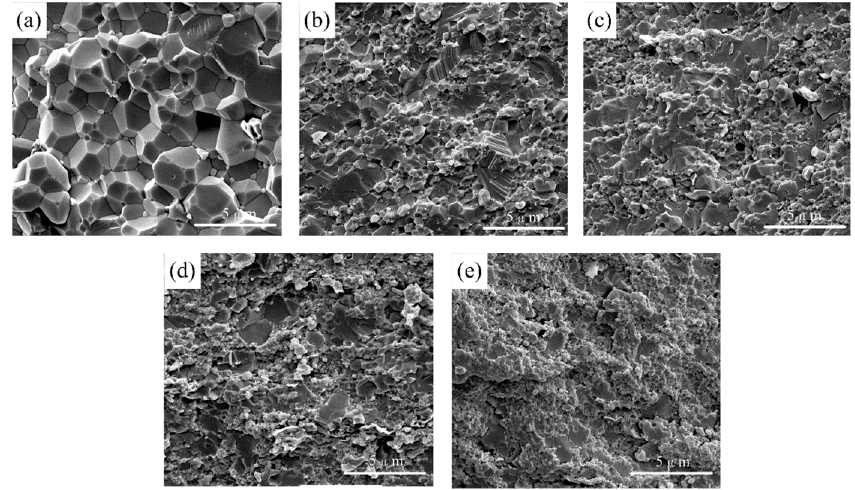
Figure 6. SEM morphologies of fracture surface of ( a ) composite F, ( b ) composite G, ( c ) composite H, ( d ) composite I, and ( e ) composite C.